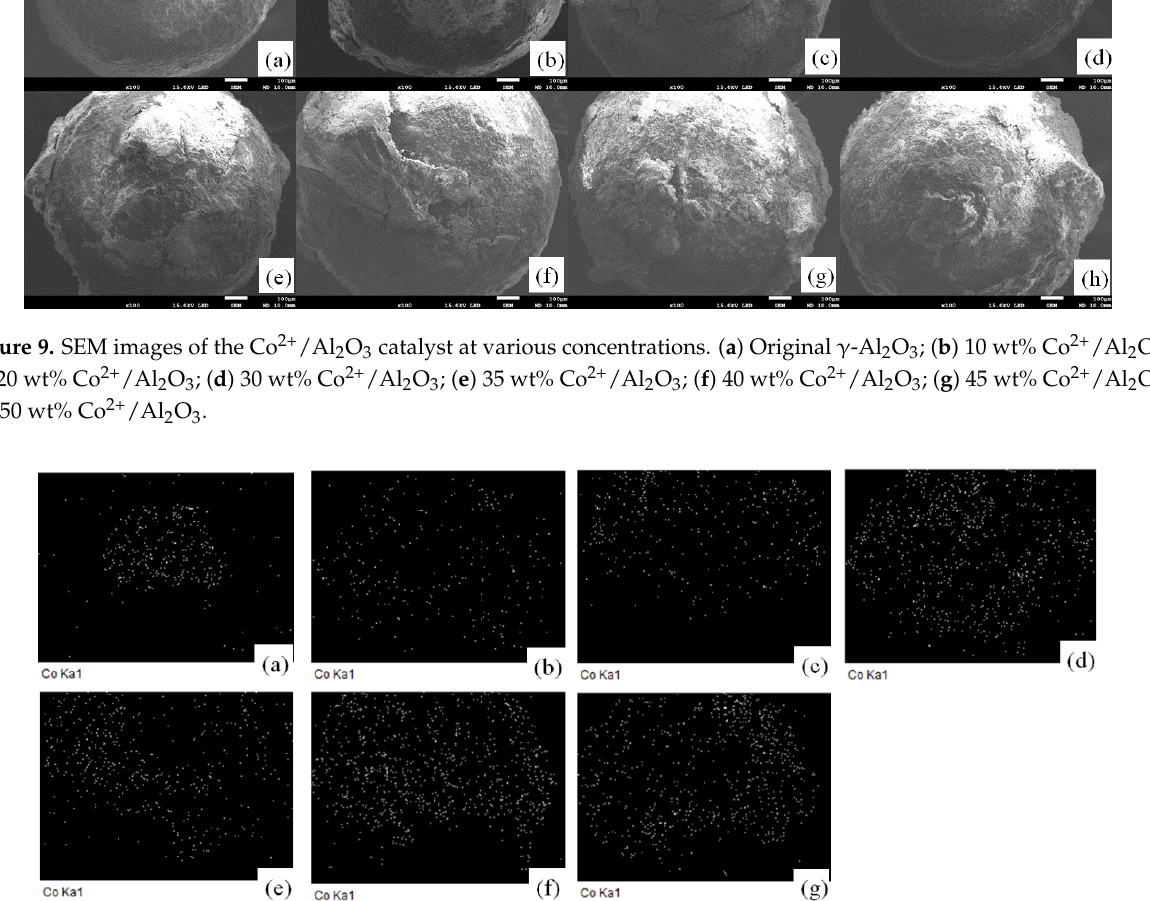
Figure 10. Mapping cobalt distribution map . ( a ) 10 wt% Co 2+ /Al 2 O 3 ;( b ) 20 wt% Co 2+ /Al 2 O 3 ; ( c ) 30 wt% Co 2+ /Al 2 O 3 ; ( d ) 35 wt% Co 2+ /Al 2 O 3 ; ( e ) 40 wt% Co 2+ /Al 2 O 3 ; ( f ) 45 wt% Co 2+ /Al 2 O 3 ; ( g ) 50 wt% Co 2+ /Al 2 O 3 .